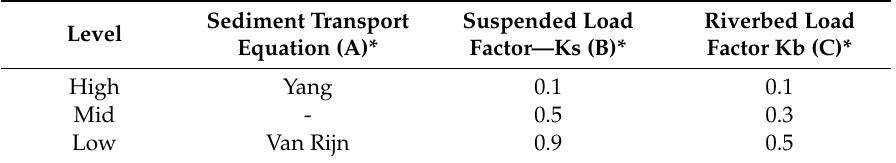
Table 6. Factors (Calibration parameters) for 3 k experimental design.